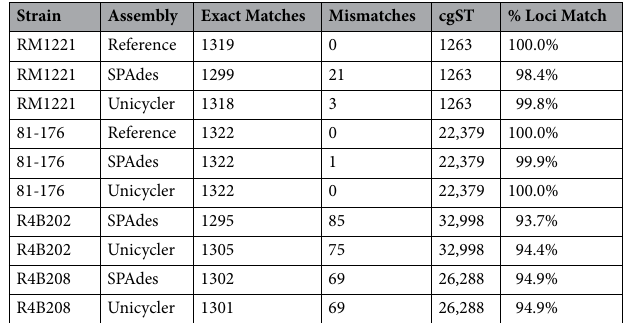
Table 9. Core genome MLST. Core genome multi-locus sequence typing was performed using the C. jejuni/C. coli cgMLST v1.0 typing scheme available at PubMLST.org to determine loci matches and the core genome sequence type